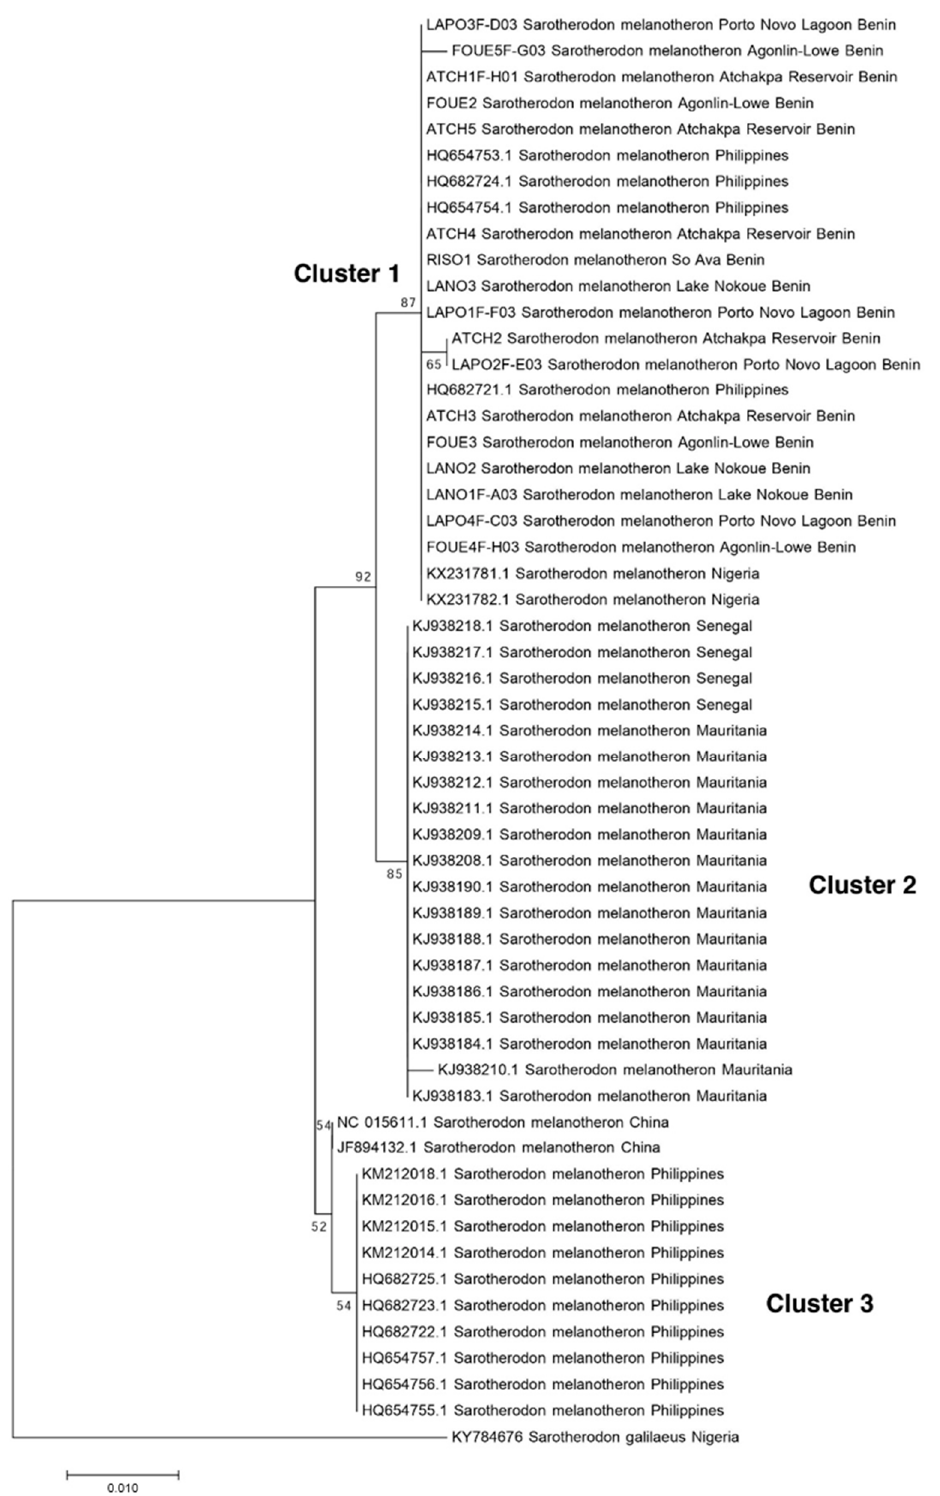
Figure 4. NJ tree constructed from the COI sequences of S. melanotheron obtained in our study and from